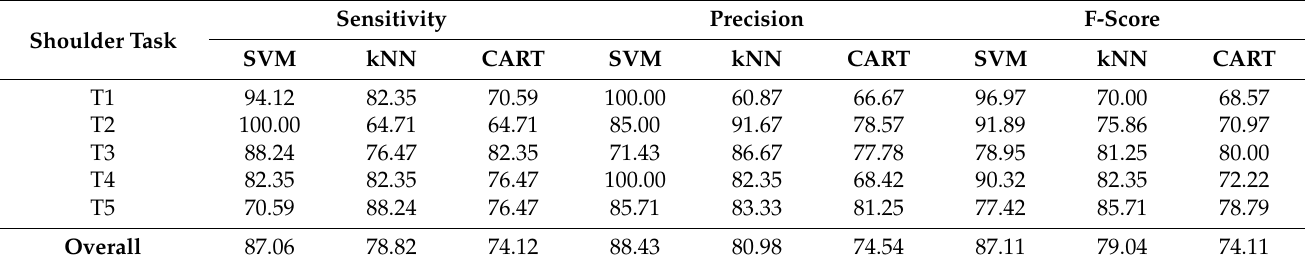
Table 4. The results of the shoulder task identification using machine learning approaches (%).